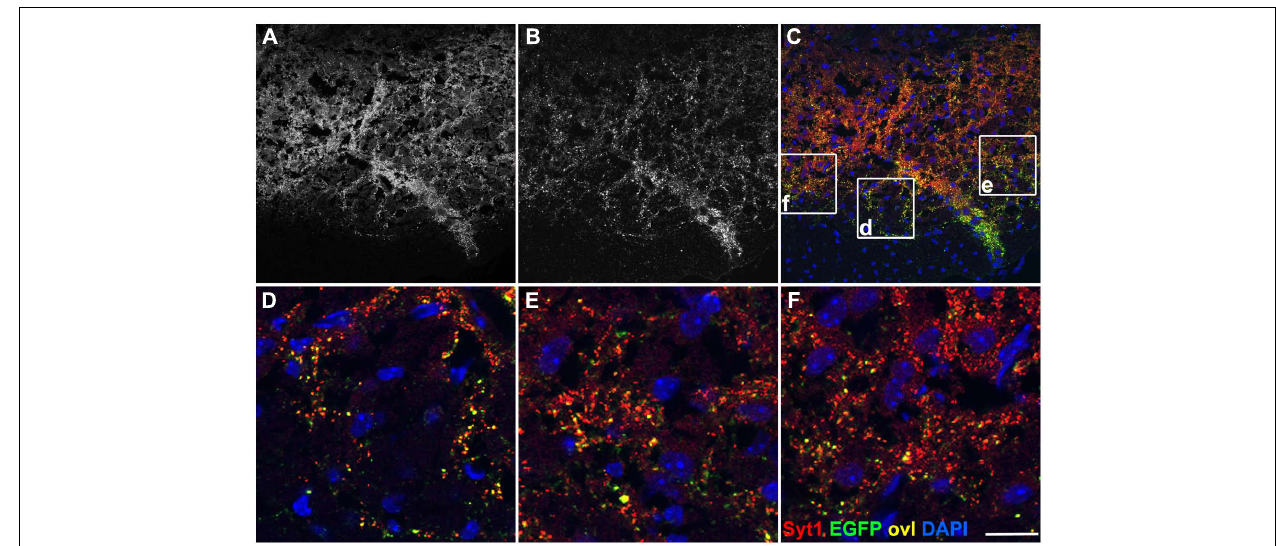
FIGURE 4 | EGFP decorates presynaptic terminals in the pons of Emx1 - Cre Rosa26 EGFP-VAMP2/ + . Sagittal sections of the pontine nuclei, immunostained for EGFP (B) and counterstained for the synaptic vesicle